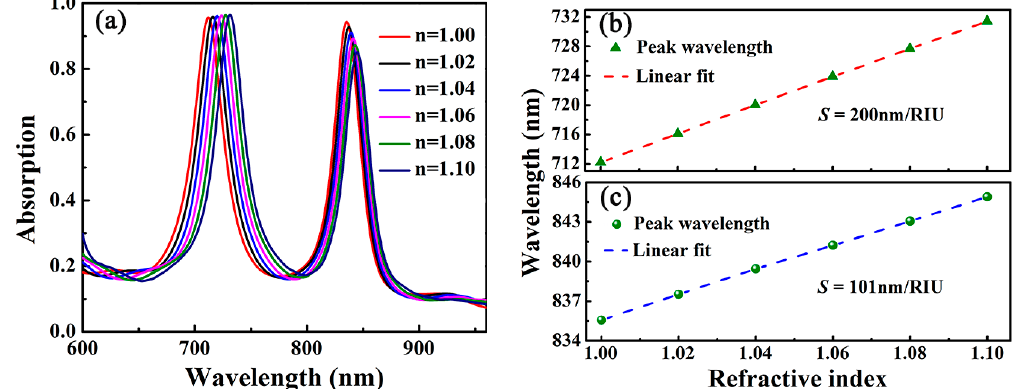
Figure 7. Sensor performance by utilizing dual-band absorption of the HRA. Other parameters are the same as those of Figure 1a. ( a ) Absorption response as a function of refractive index of the background. ( b ) Location of peak 1 as a function of refractive index of the background. ( c ) Location of peak 2 as a function of refractive index of the background.